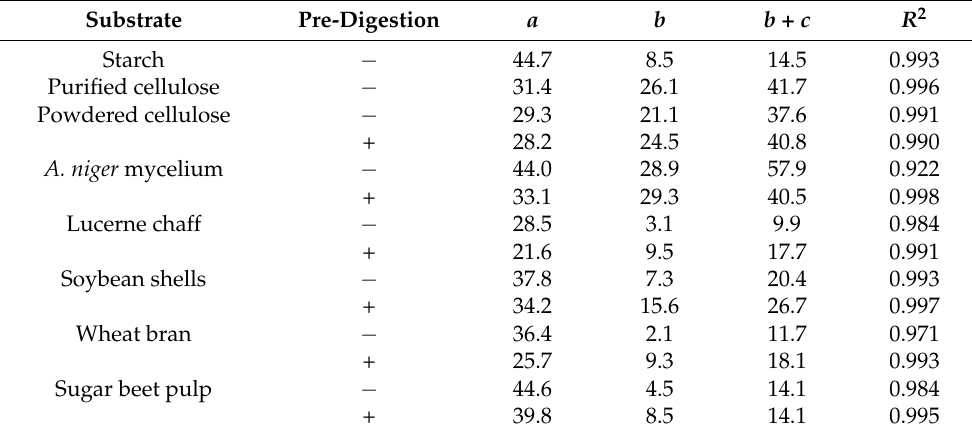
indicate difference between not pre-digested ( − ) and pre-digested (+) materials ( p < 0.01). Table 4. Estimates of model parameters of gas production courses.